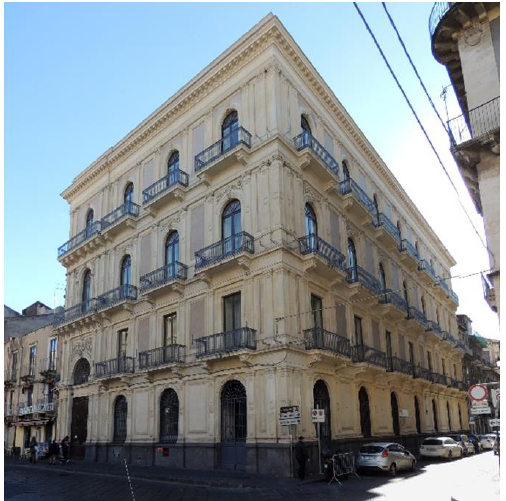
Figure 1. North- and west-facing façades of the selected building. Table 1. Thermophysical properties of the opaque envelope in the actual configuration.